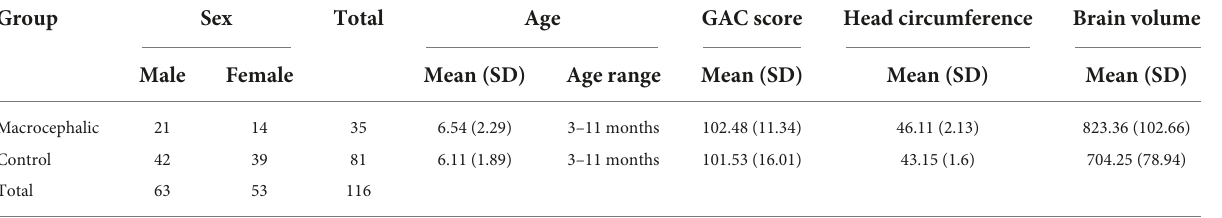
Table 3 for best model fit statistics by TFW for spectral power, Supplementary Table 6 for best model fit statistics by TFW for ITC and Supplementary Table 9 for best model fit statistics by peak-to-peak measure).